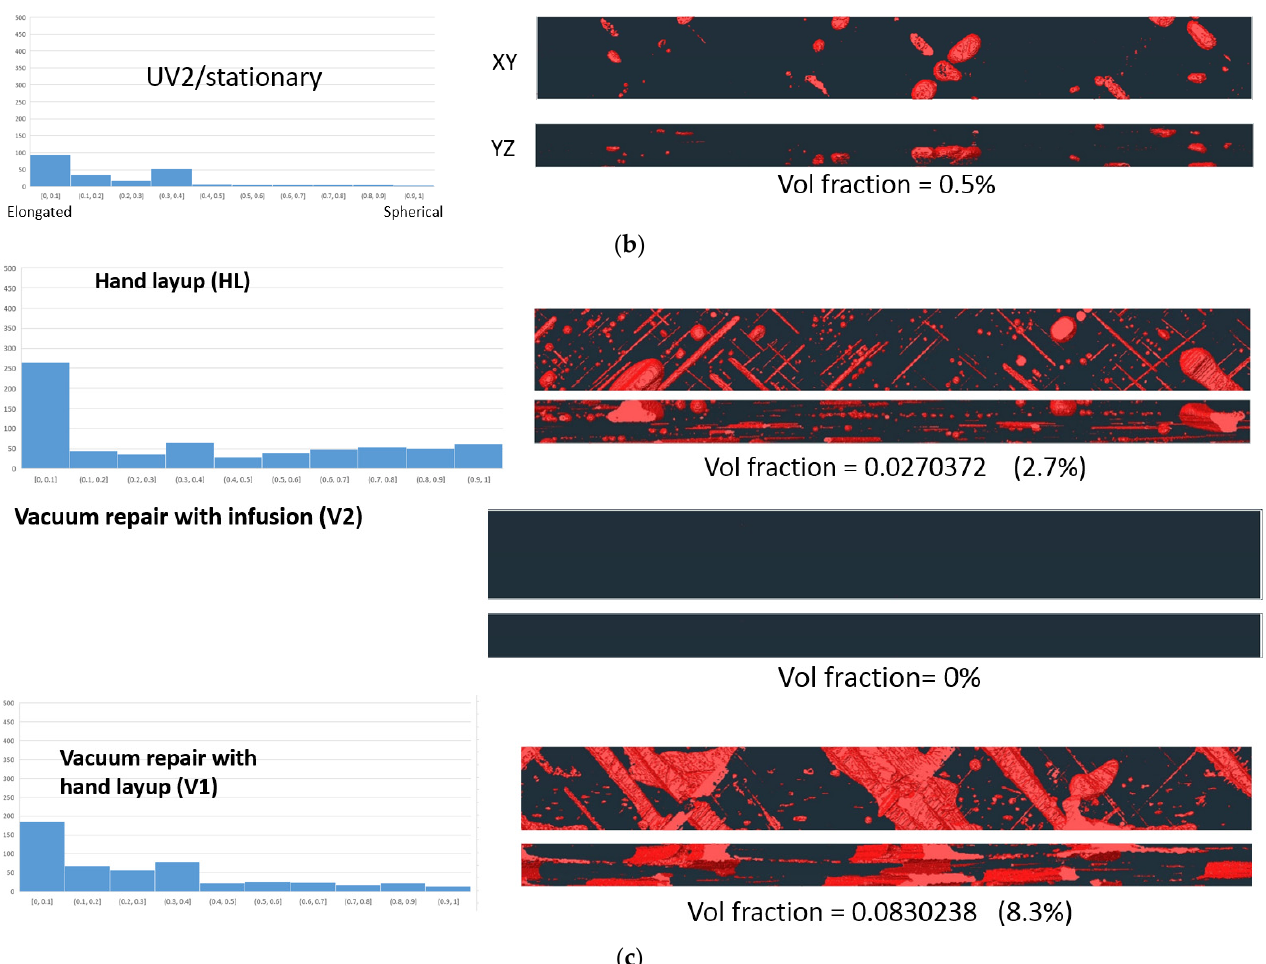
Figure 11. Volume fraction of voids and shapes of voids (elongated versus spherical) for tested samples: ( a ) vacuum repair with hand layup/hand layup/handheld UV, ( b ) high-temperature curing/stationary UV, and ( c ) hand layup/vacuum repair with infusion/vacuum repair with hand layup.